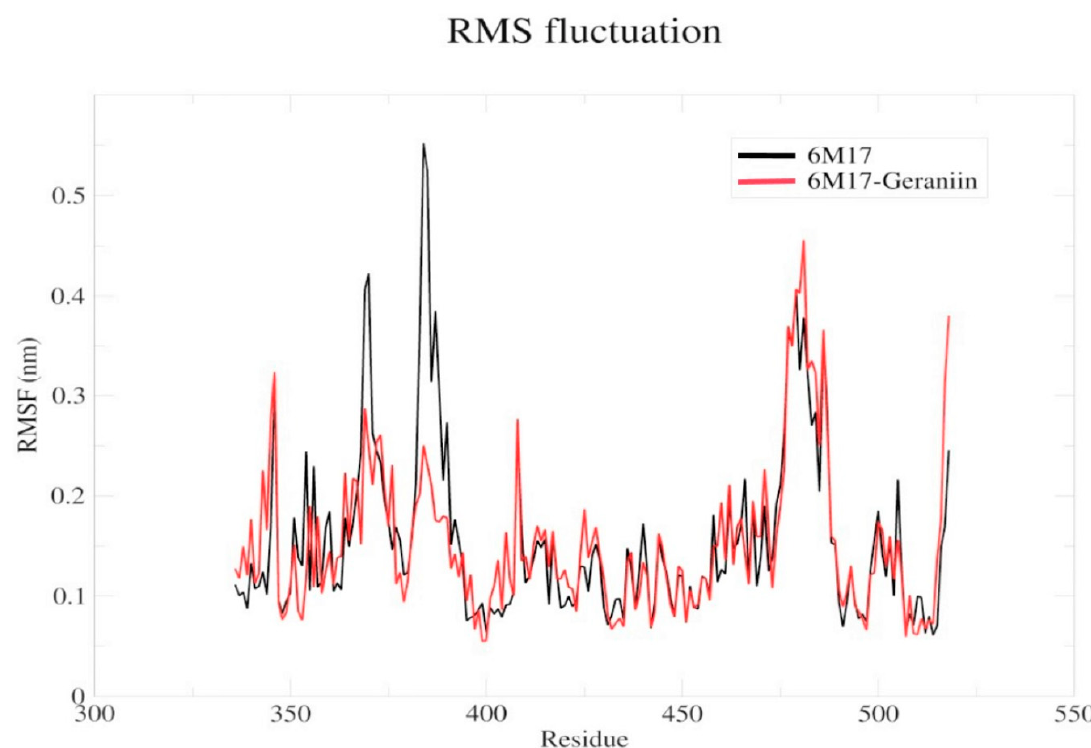
Figure 4. Backbone RMSDs of the apo 6M17 and 6M17–geraniin complex structures. RMSD Å (nm) is the ordinate, and time ns is the abscissa. The black and red lines indicate the 6M17 and 6M17–geraniin complex, respectively. (RMSD - Root Mean Square Deviation).